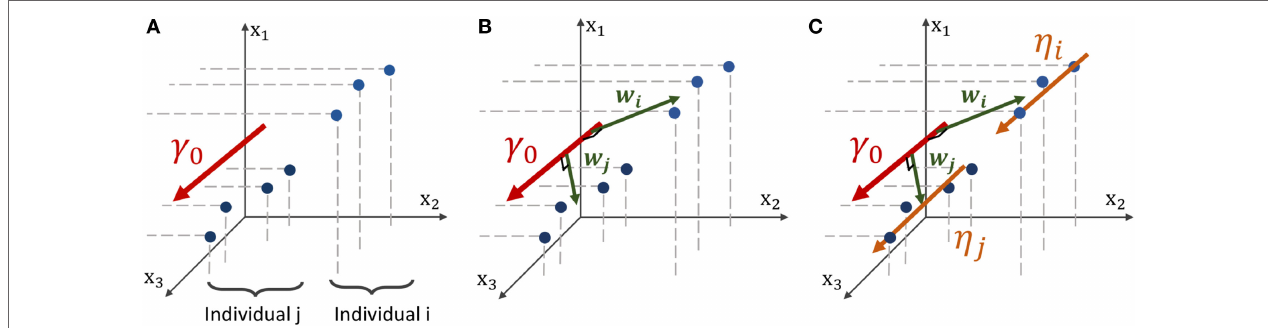
FIGURE 3 | Geometric description of the construction of the mean and individual spatiotemporal trajectories in the space of measurement, which is the Riemannian Manifold M that embeds both the real observations and the trajectories. (A) Three-dimensional space embedding individual observations (blue points) of two individuals and the mean spatiotemporal trajectory γ 0 (red curve). (B) The spatial variations from the group-average trajectory γ 0 to the individual observations are captured in individual vectors w i and w j , called space shifts. (C) The vector w i is parallel-transported along γ 0 (orange vectors) to define a parallel curve η i that characterizes the individual spatiotemporal